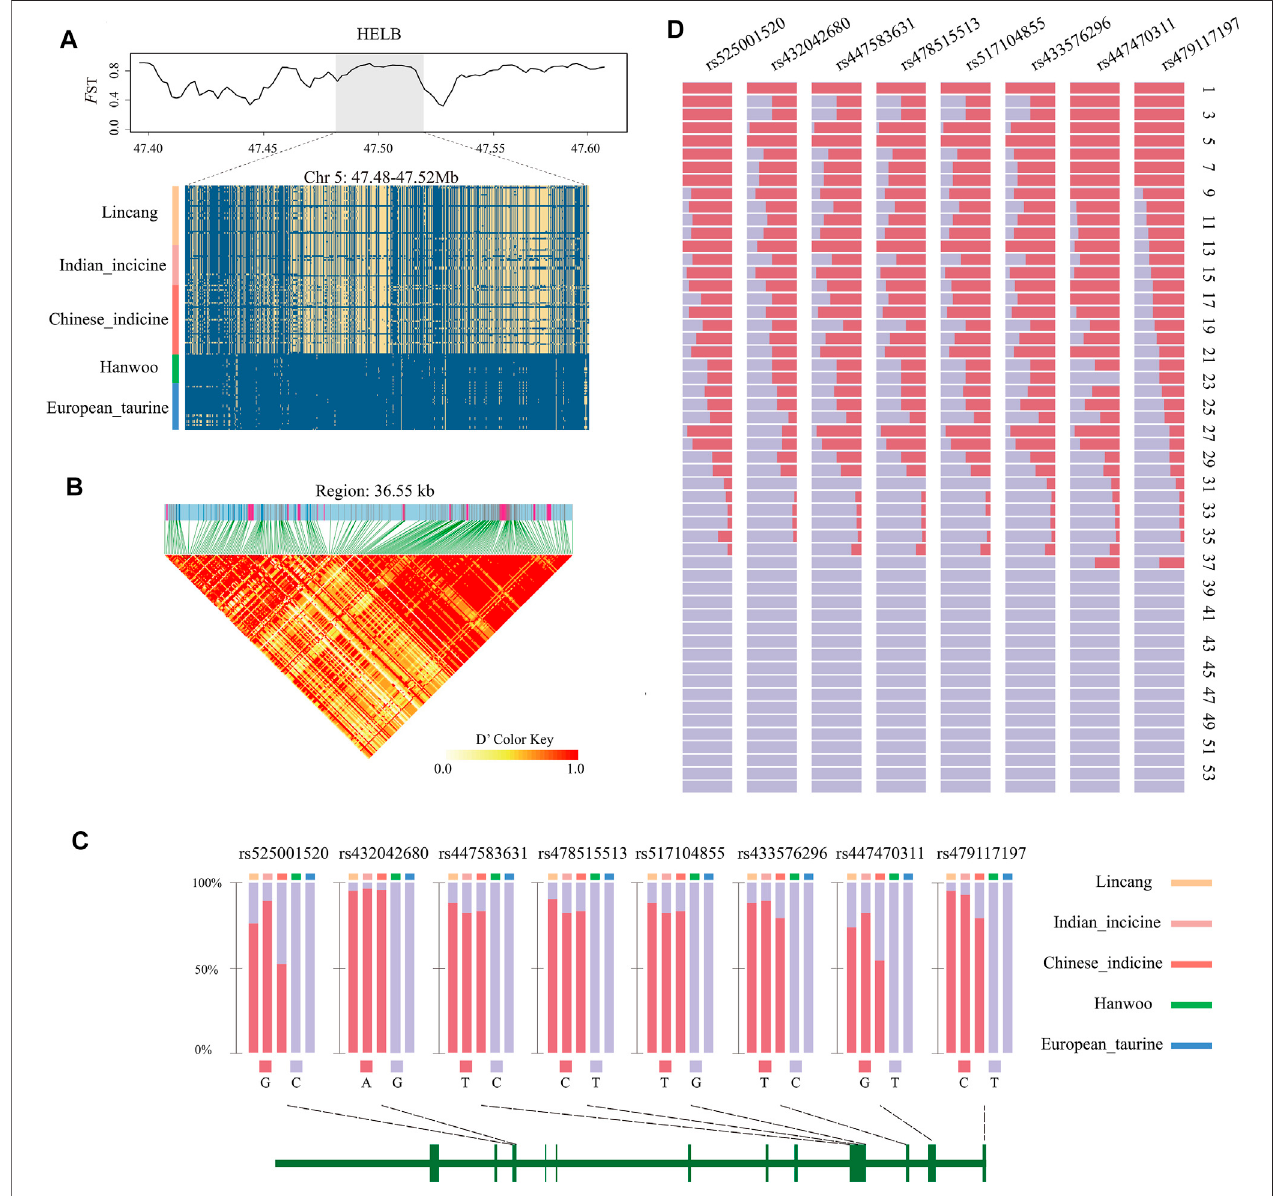
FIGURE 4 | Characteristics of the HELB gene. (A) F ST , TajimaD, and degree of haplotype sharing across populations. The major allele at each SNP position is colored in yellow. (B) Allele frequency of the eight missense SNPs in each group and the schematic structure of genes. The vertical bars in the structure diagram represent the exon region. (C) LD plot of SNPs. LD values (D ′ ) between two loci are detailed in boxes (D ′ = 0 – 1). D ′ = 1 indicates perfect disequilibrium. (D) Allele frequency of the eight missense SNPs across the 54 populations in the BGVD. Population names associated with serial numbers are as follows. 1 Tharparkar;